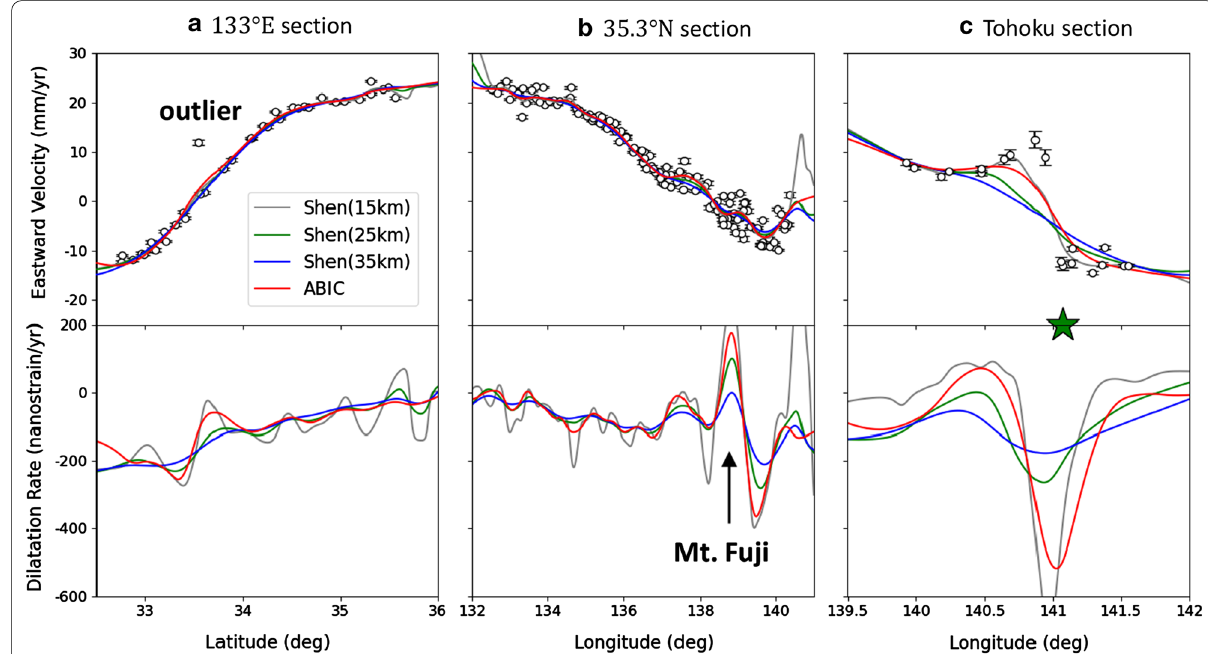
Fig. 6 Cross sections of the estimated eastward velocity and dilatation rates. The locations of the cross sections are indicated by the solid lines in Fig. 2. Results of different D values are presented for Shen’s method. Observed velocity data within ± 0.2 ◦ longitude or latitude from the sections are also plotted. Error bars show the estimated uncertainty of velocity data at each site. The green star in c indicates the epicenter of the 2008 Iwate-Miyagi inland